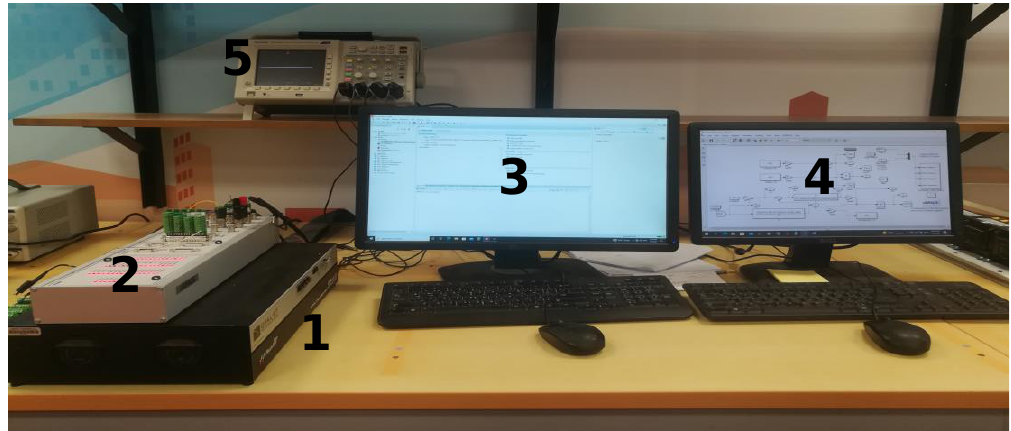
Figure 9. The test bench. 1 — OP4510 simulator; 2 — dSPACE ds1104 Controller Box; 3 — RT-LAB monitor console; 4 — dSPACE control desk monitor; 5 — Digital oscilloscope.